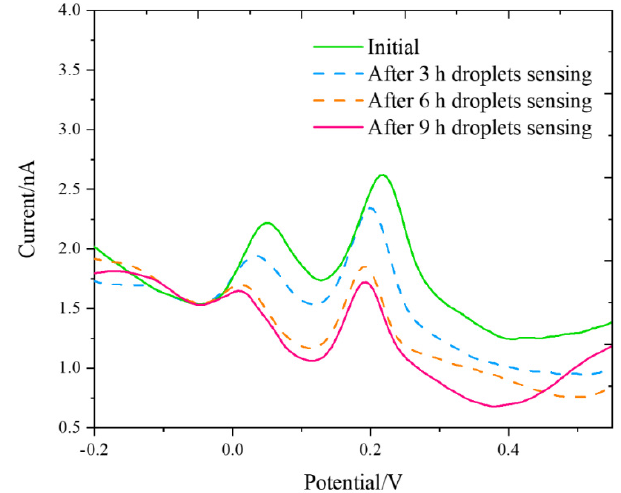
Figure 7. DPV plots of the nafion–MWCNT-modified BDUNCD microelectrode in a ternary mixture of 1 µ M 5-HT, 100 µ M AA, and 1 µ M DA and at 0th, 3rd, 6th, and 9th h. The flow rate was 0.1 mL/min with a droplet volume of 0.02 mL, a background flow rate of 0.1 mL/min, and a potential of +0.35 V with a droplet frequency of 2 min.